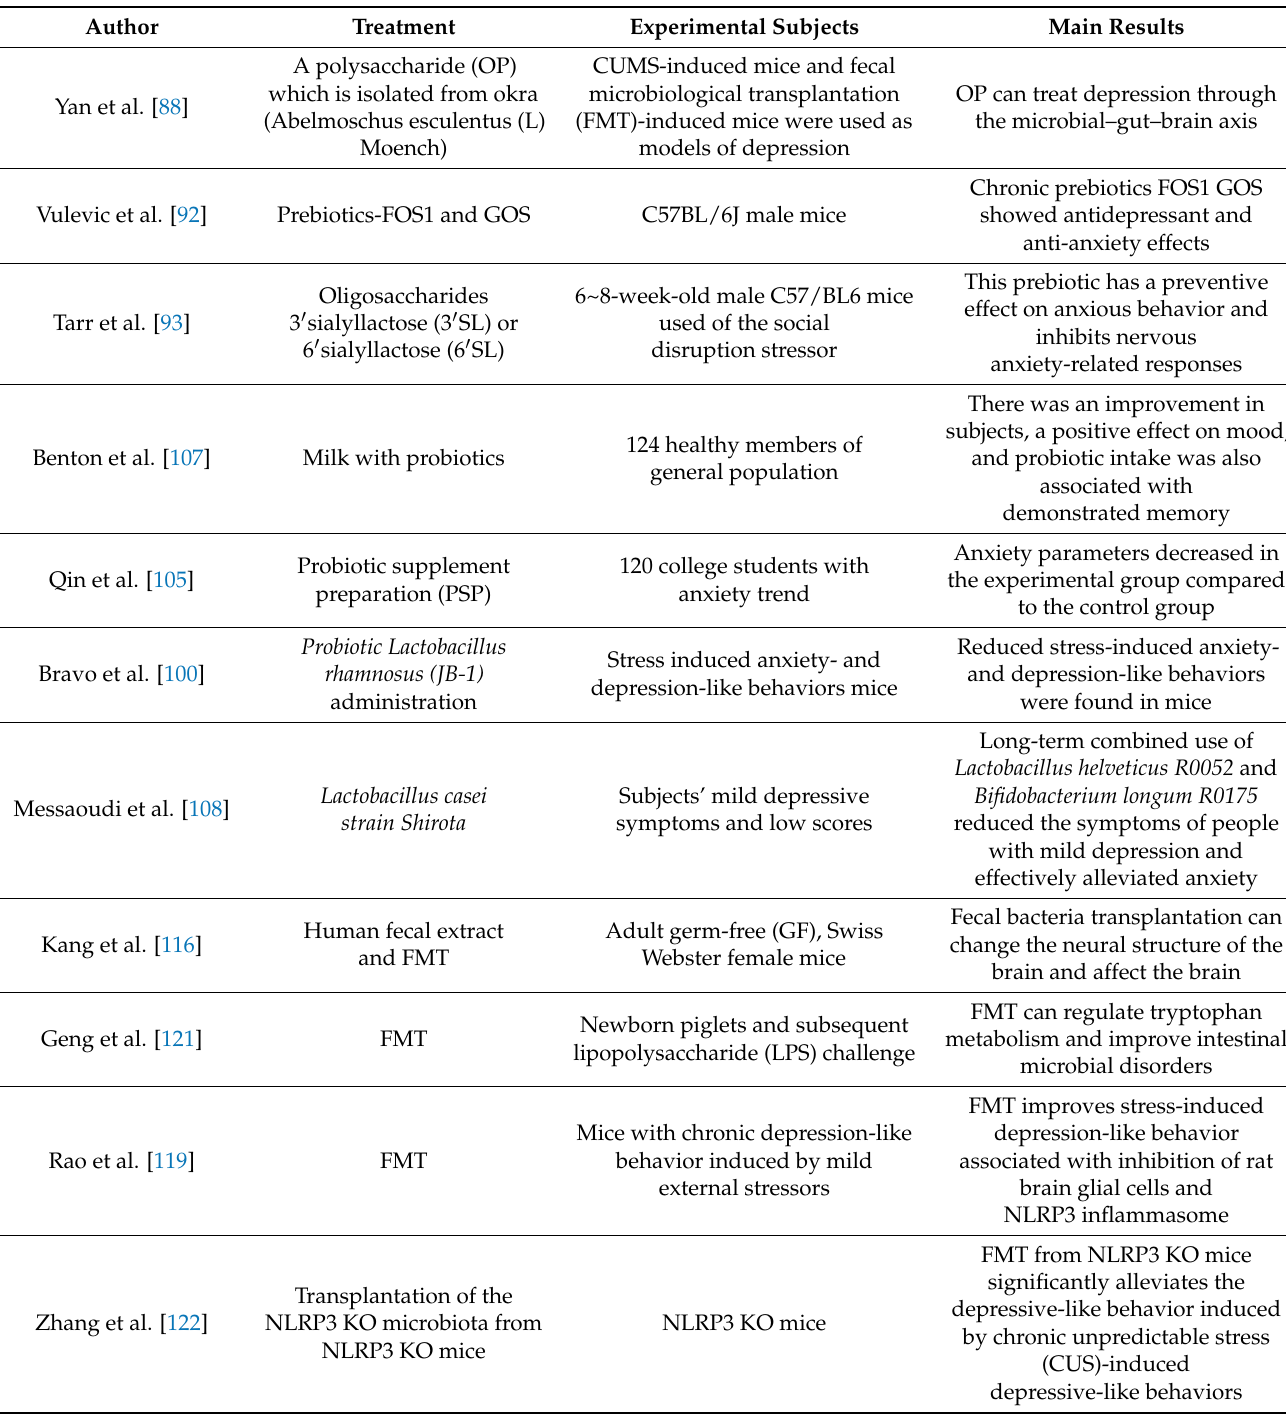
Table 1. Effects of microbiological treatments on mouse models and human